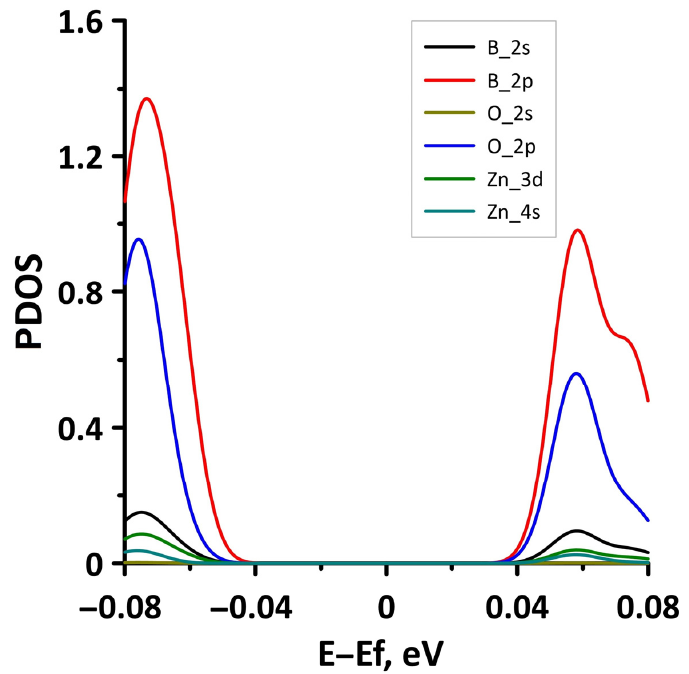
Figure 16. Fragments of PDOS near the Fermi level (shifted to 0 eV) of borophene/ZnO heterostruc- ture under uniaxial stretching by 10%.